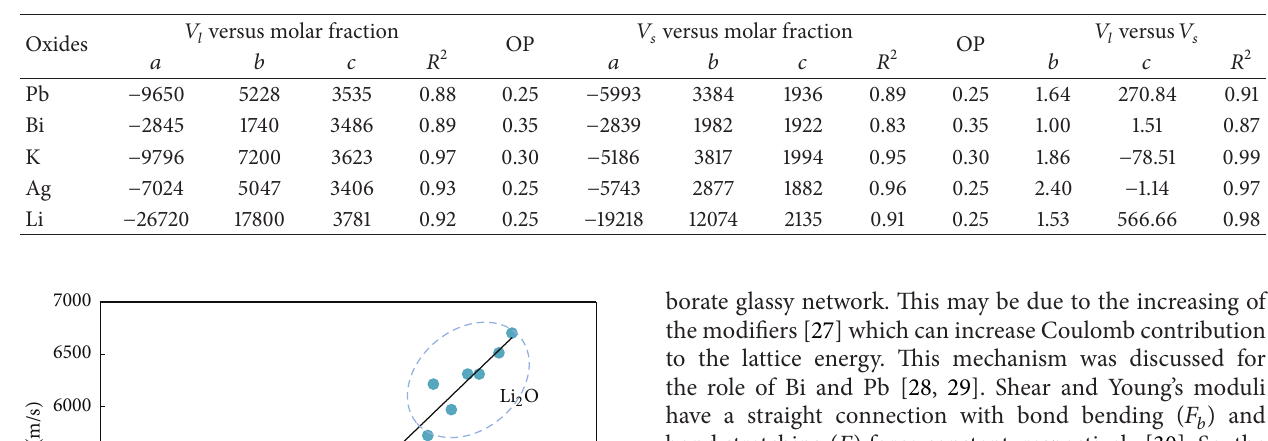
Table 3: Nonlinear regression analysis of the variables ( 𝑦 = 𝑎𝑥 2 + 𝑏𝑥 + 𝑐 ) for longitudinal and transverse ultrasonic velocities as well as optimum contents of modifier oxides (op = optimum points) [22, 23].